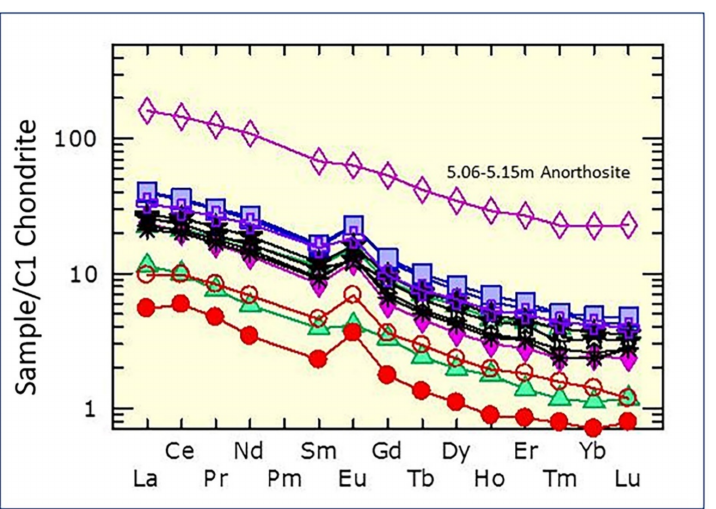
Figure 4. Chondrite-normalized (normalization factors from [16]) REE diagram for samples from hole VB95-129.